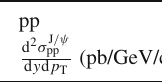
tematic second. A global systematic uncertainty of 3.2% (3.7%) affects all PbPb (pp) fiducial cross sections. The table corresponds to the top panel of Fig. 4